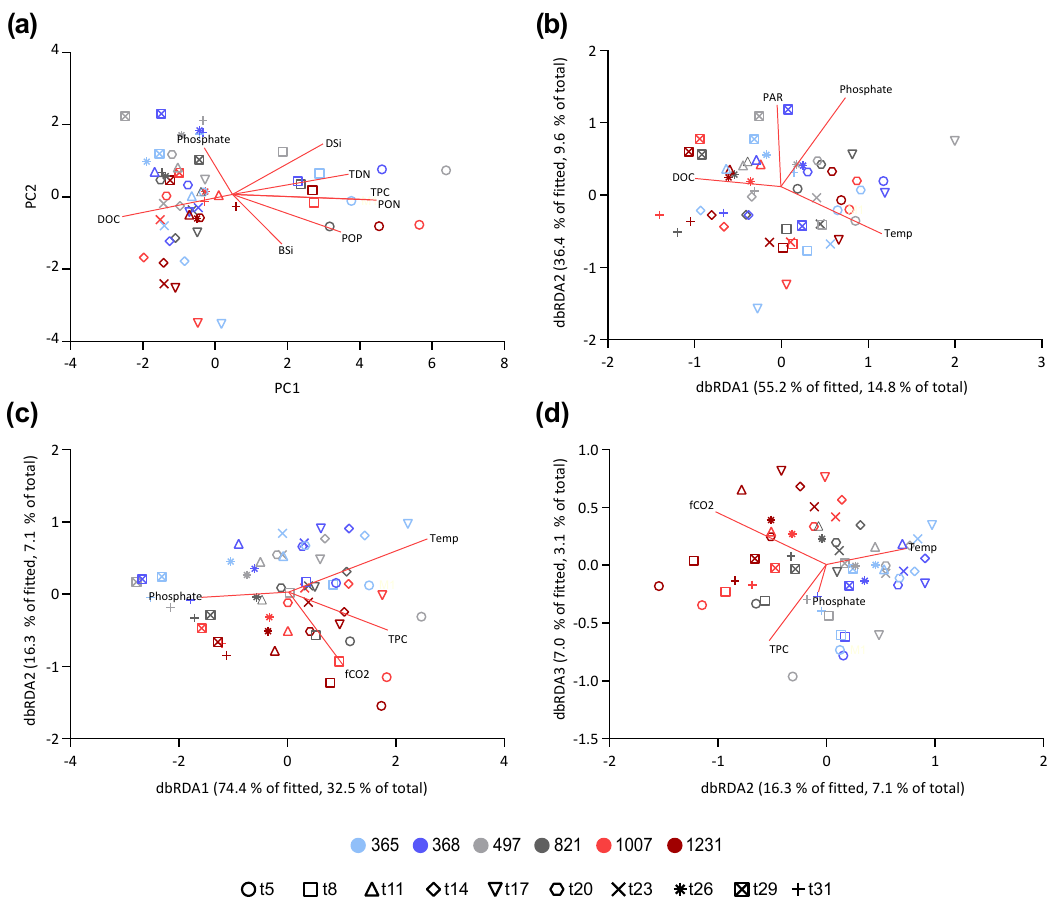
Figure 6. (a) First and second axis of a principal component analysis (PCA) calculated on normalized variables of dissolved and particulate nutrients ( n = 60). The set of variables and the eigenvectors of the first four axes can be derived from Table 2. (b) Ordination of a distance- based redundancy analysis (dbRDA) for visual interpretation of distance-based linear modelling (DistLM) between physical/chemical pre- dictor variables and metabolic variables as well as (c–d) abundances of functional bacterial and phytoplankton groups. A table comprising the set of variables used for DistLM can be derived from the Supplement (Table